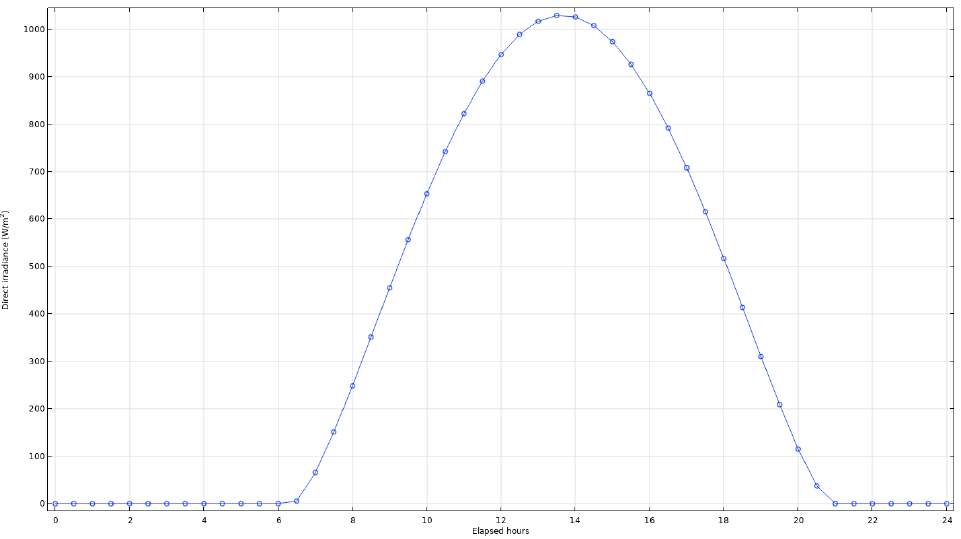
Figure 8. Direct Irradiance (Wm − 2 ) received by the cell at 2019’s summer solstice, referent to the wings.